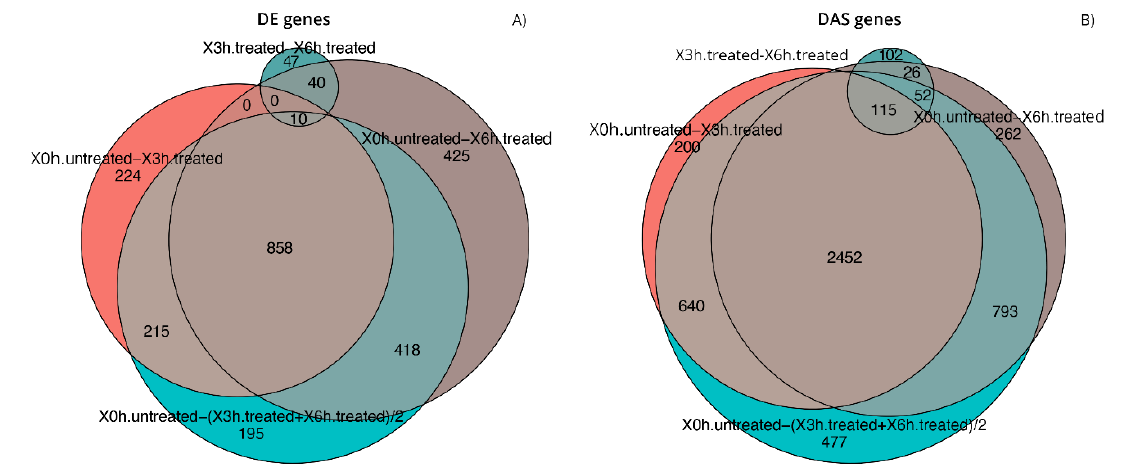
Figure 3. Comparison of the gene lists generated during di ff erential expression analyses. Euler diagrams of DE ( A ) and DAS ( B ) genes identified during expression analyses in considered conditions of experimental design, setting the contrast groups as 0 h.untreated versus 3 h.treated, 0 h.untreated versus 6 h.treated, 3 h.treated versus 6 h.treated, 0 h.untreated versus (3 h.treated + 6 h.treated)/2.